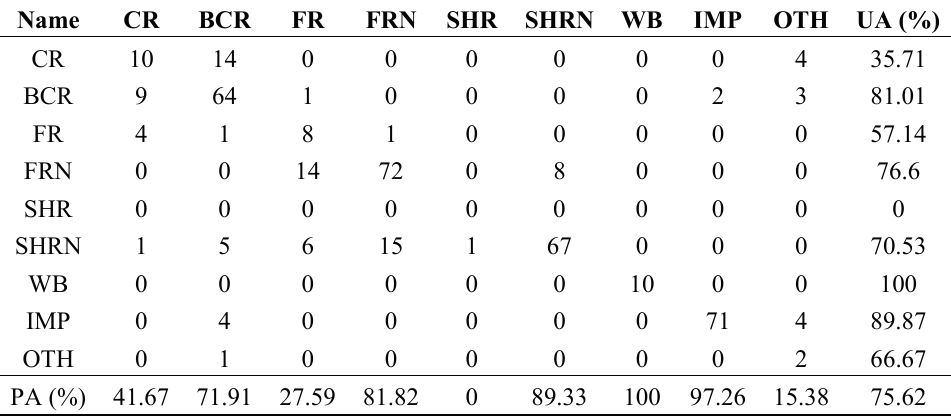
Table 7. Confusion matrix for a land cover map on day of year (DOY) 308 in process P8 (Overall Accuracy: 75.62%. CR = Croplands; BCR = Bare croplands; FR = Forests; FRN = Forests, leaf-off; SHR = Shrublands; SHRN = Shrubs, leaf-off; WB = Water bodies; IMP = Impervious; OTH = Grasslands/Barren lands/Grasslands, leaf-off; UA = user accuracy; PA = producer